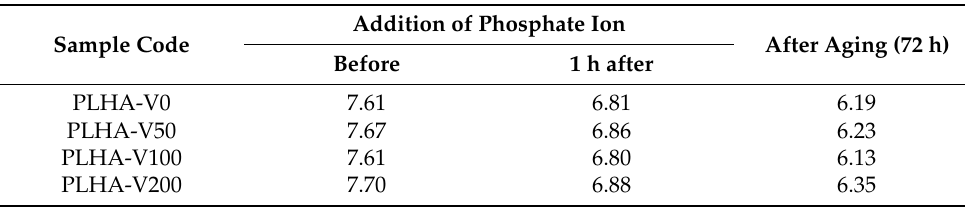
Table 1. pH values of the PLHA-V x solutions under different conditions. Sample